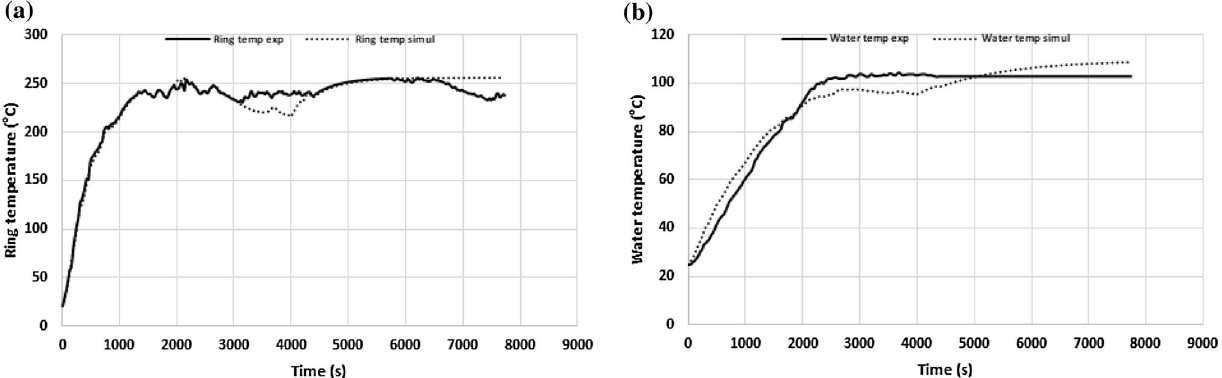
Fig. 12 Experimental (solid) and simulated (dotted) ring a) and water b) temperatures along a water ebullition test, in the configuration with a